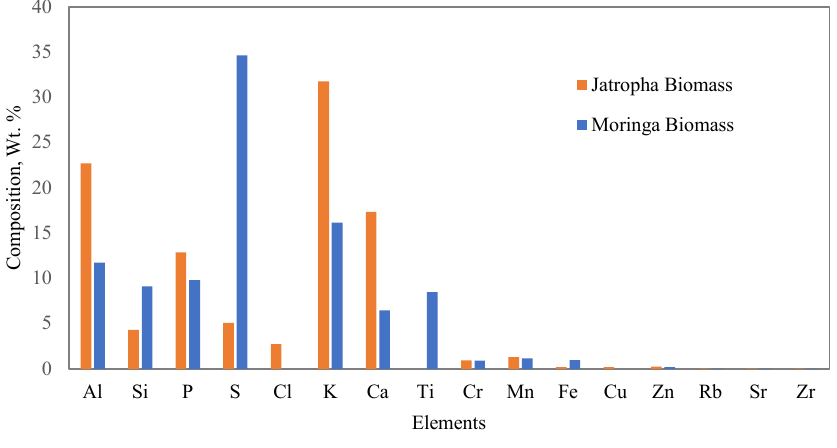
Fig. 1. Elemental composition of Jatropha and Moringa biomass.